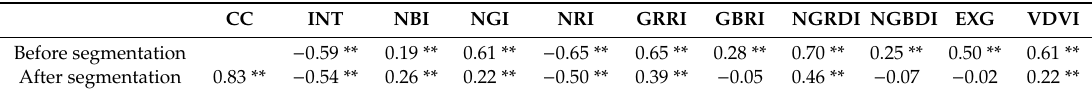
Table 5. Correlation analysis results of image feature parameters and the canopy volume parameter (CVP).